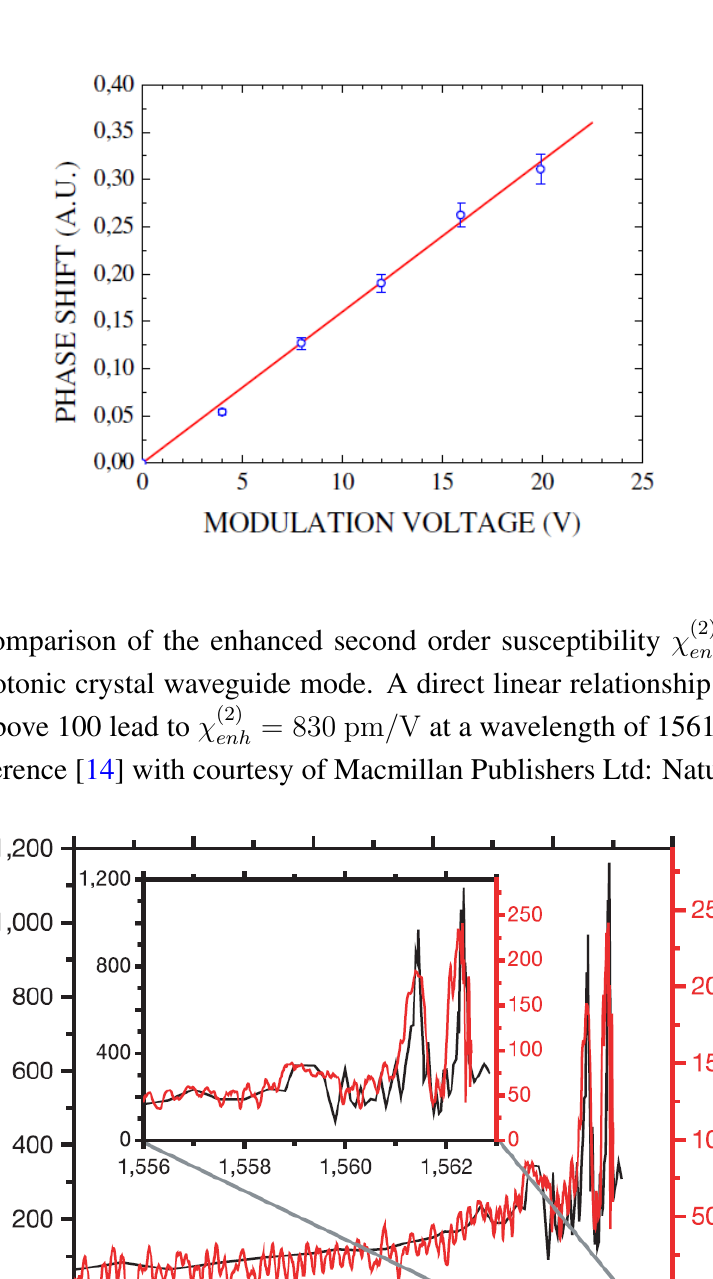
Figure 13. Linear relationship between observed phase shift and modulation voltage indicates the underlying Pockels effect. Figure is taken from Reference [47] with courtesy of IEEE.